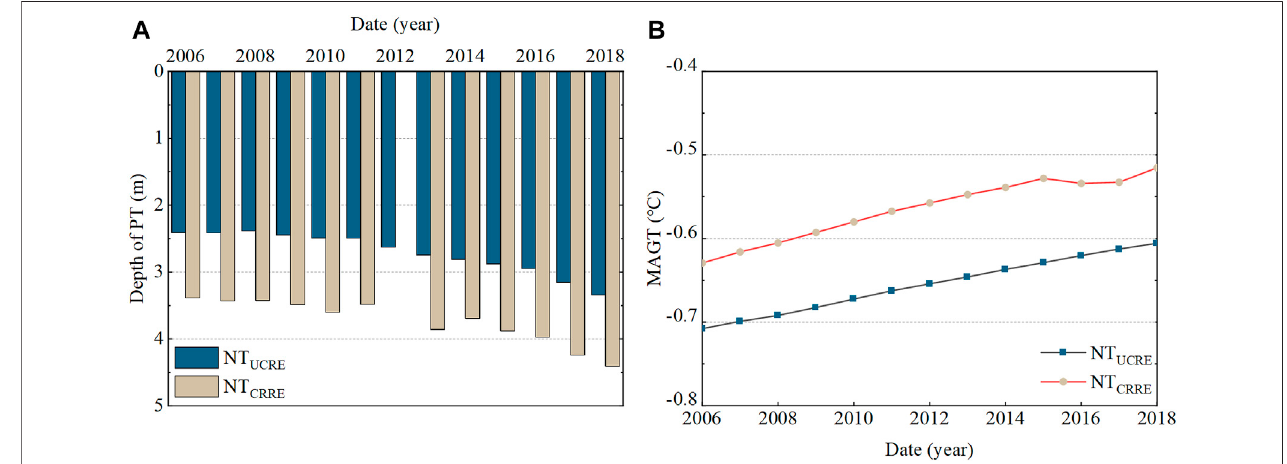
FIGURE 4 | Permafrost temperature variations at depths of 4.5 m (A) and 10 m (B) beneath the natural sites.